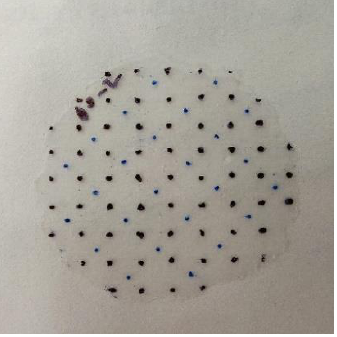
Figure 19. Wafter sample of 56 kGy with ~1 mm × 1 mm grids.